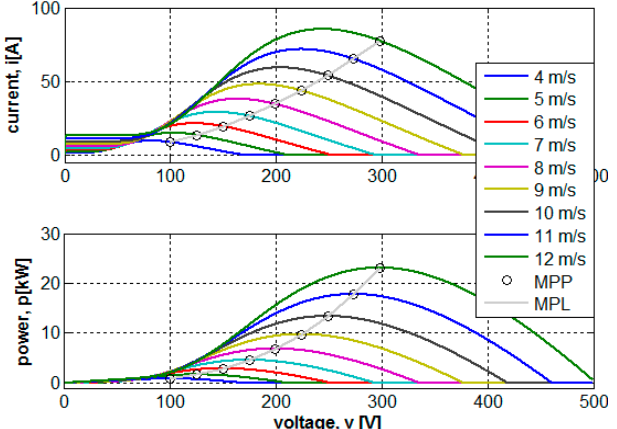
Figure 4. Electrical side characteristics of the wind turbine generator (WTG)-DC generator (DCG) and MPLs calculated according to (17) and (18).